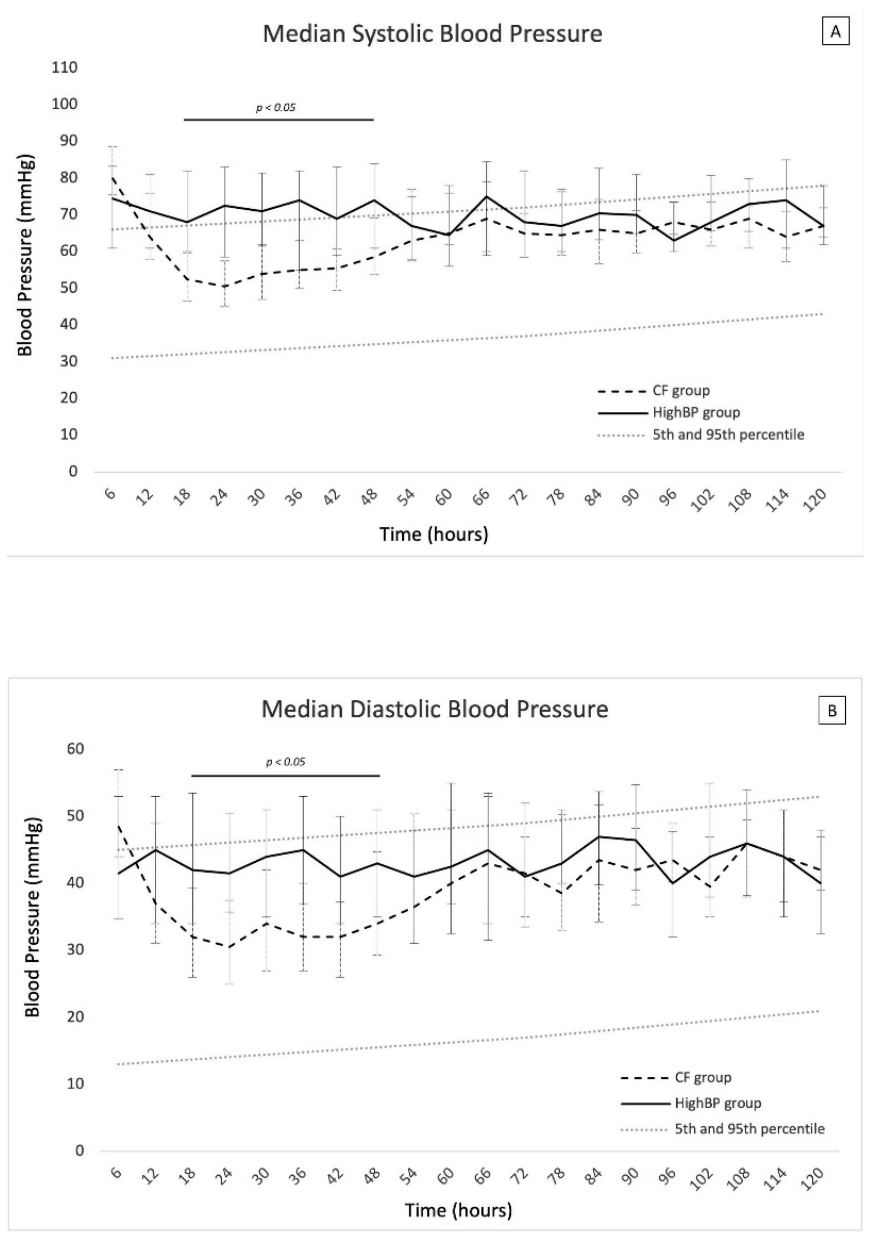
Figure 2. Systolic ( A ) and diastolic ( B ) blood pressure of recipient twins with cardiac failure (CF group) and with isolated high systolic blood pressure (HighBP group). All data are presented as median values with 1st and 3rd quartiles. Between 18 and 48 h of life, systolic and diastolic blood pressure values were signifi- cantly lower in the CF group than in the HighBP group. During this period, systolic and diastolic blood pressure in the CF group were approximately at the mean and at the 30th percentile of normal values for gestational age, respectively. AKI was more frequent in the CF group than in the HighBP group (93% vs. 25%; p < 0.001) and also more severe (grade 3 = 87% vs. 0%, p < 0.001). Urine output was similar in both groups at 12 h of life but decreased to less than 1 mL/kg/h between 18 and 36 h of life in the CF group, whereas it remained above 2 to 3 mL/kg/h in the HighBP group (Figure 3). Blood urea nitrogen and serum creatinine increased significantly in the CF group and were significantly higher than in the HighBP group between day 1 and day 4 and at day 1 and 2, respectively (Table 2, Supplementary Figure